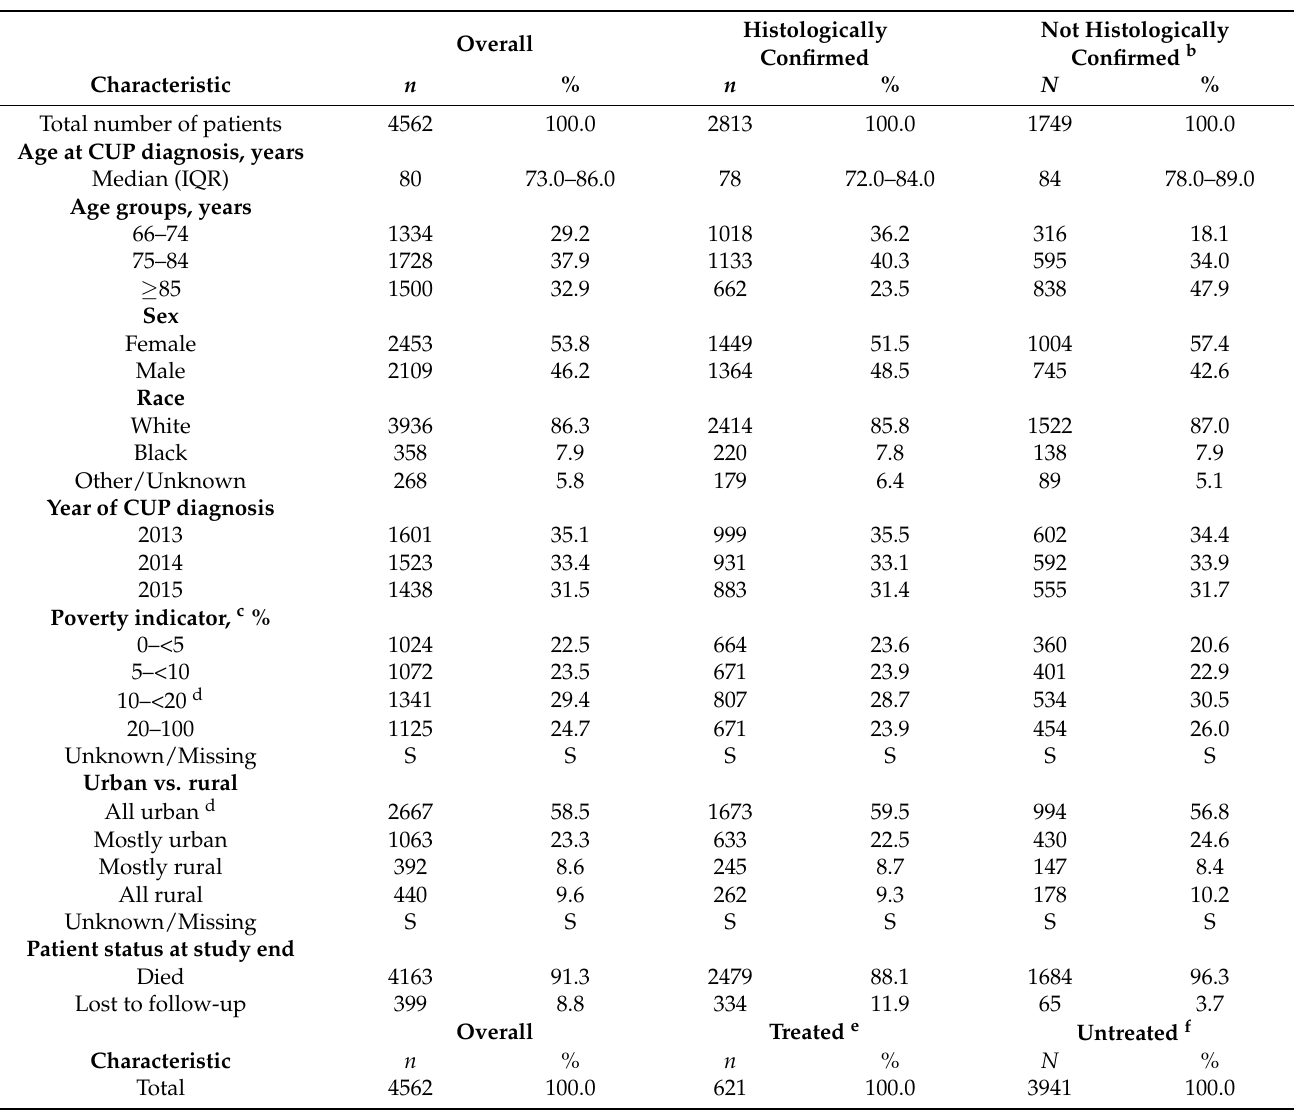
Table 1. Baseline demographics a and clinical characteristics of patients with CUP, overall, and by receipt of anticancer